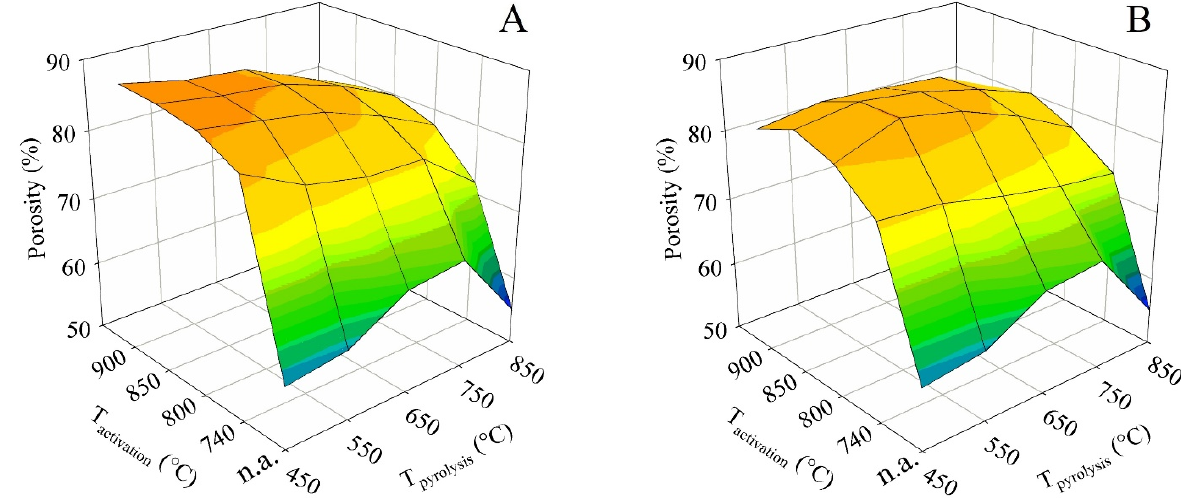
Figure 9. The impact of the pyrolysis and activation conditions on porosity for series ( A , B ).